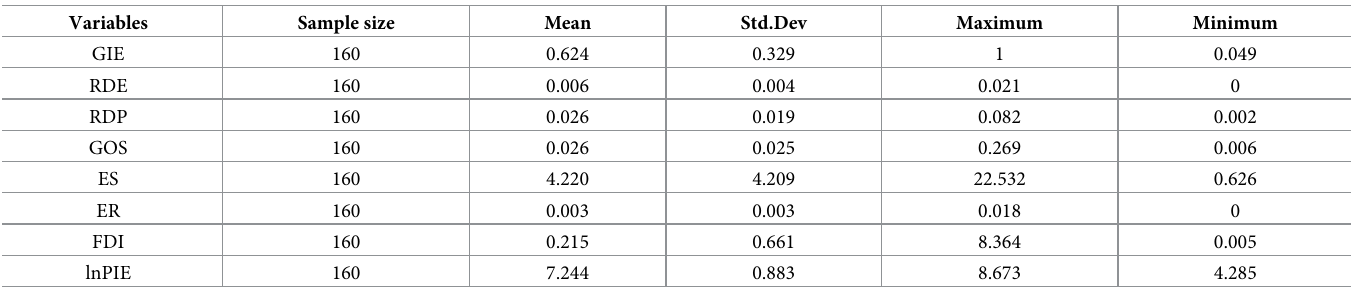
Table 2. Descriptive statistics of variables.